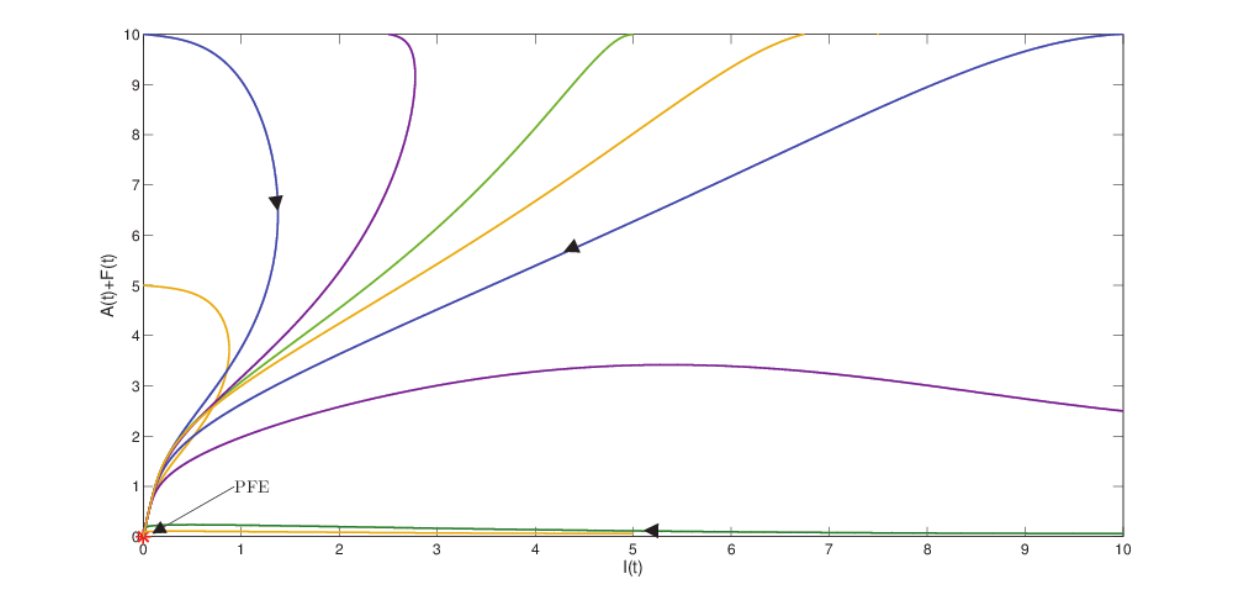
Fig. 2. Illustration of the case of global asymptotic stability of the PFE